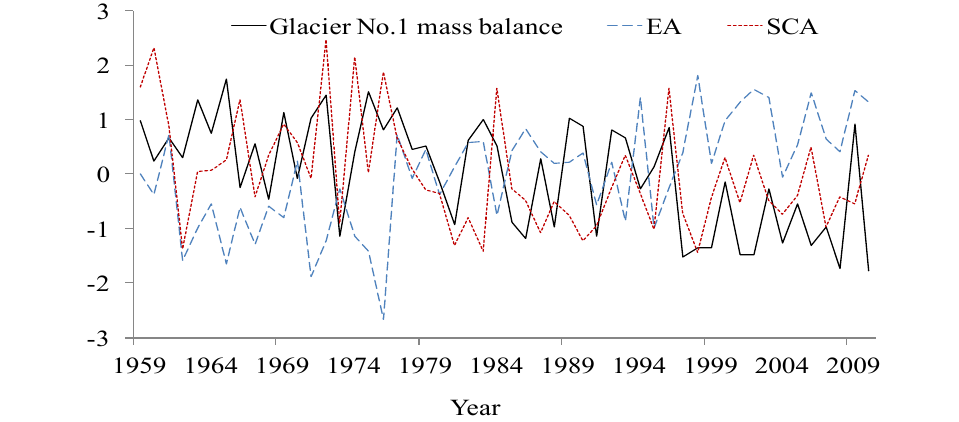
Figure 5. Comparison of the mass balance of Glacier No. 1 with significantly related climate indices.